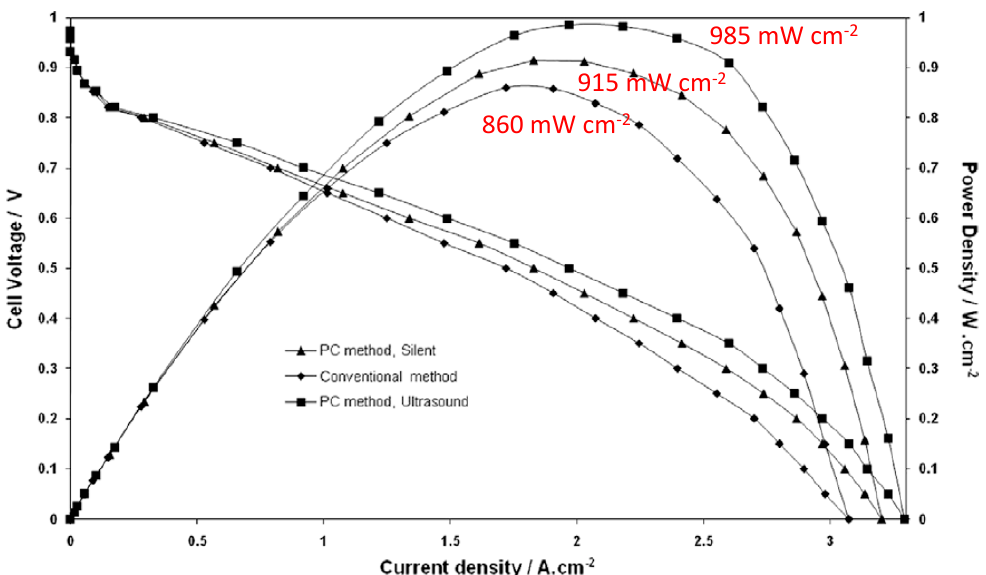
Figure 18. I–V and power curves for PEMFC electrodes prepared by (ii) the sonoelectrochemically, (ii) galvanostatic or Pulsed Current (PC) method only (i.e., silent conditions) and (ii) conventional method. Modified from [25].